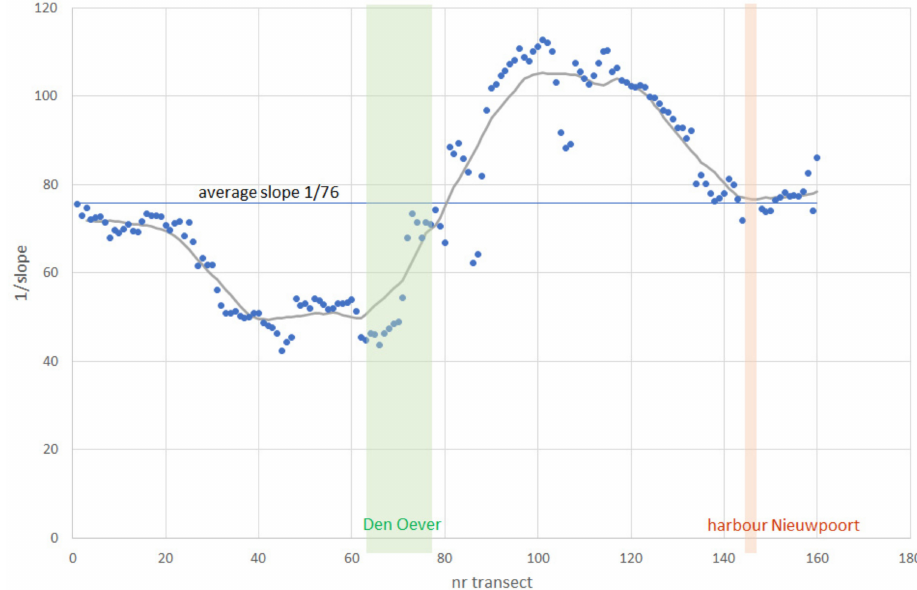
Figure 5. Variability of the slope of the active beach and shoreface zone in the study